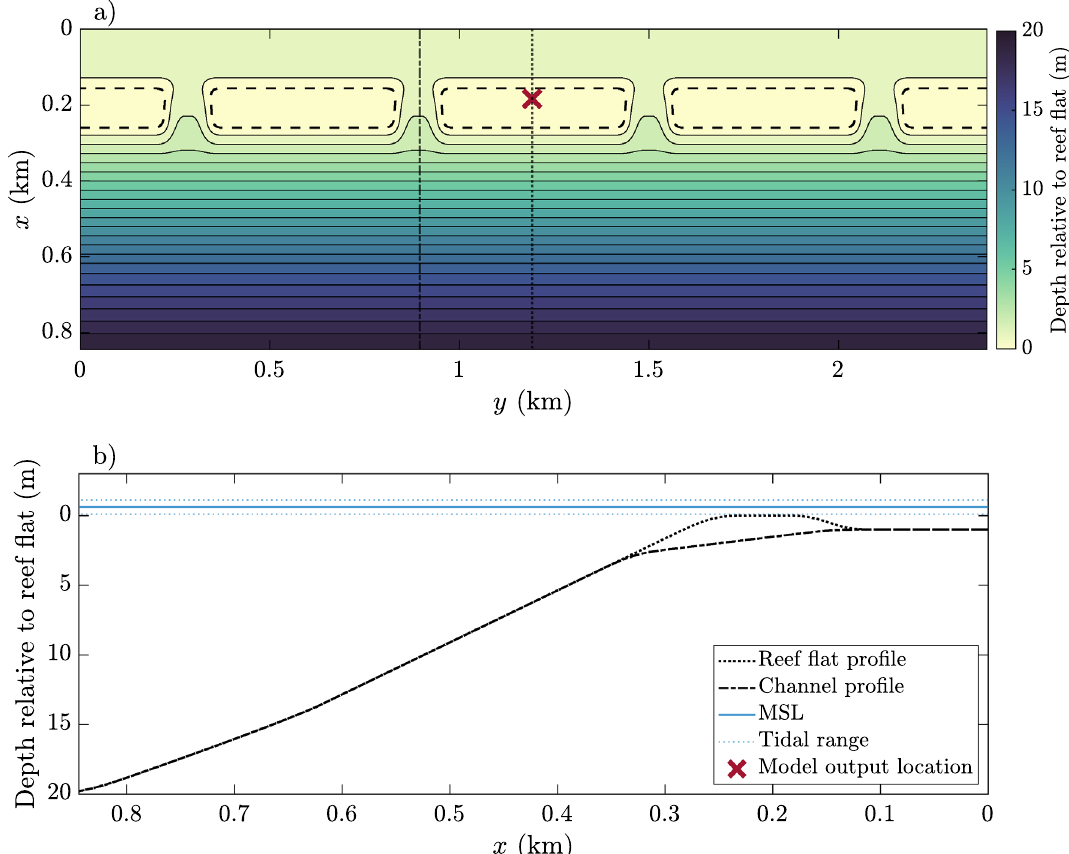
Figure 2. Model domain. ( a ) Bathymery. The area within the bold, dashed lines indicates the reef flats and the part of the domain where the drag coefficient is varied between model runs. Vertical dotted (dot-dash) line indicates profile along the reef flat (channel) in ( b ). The red marker shows the location of model outputs in Figs. 8 and 9. ( b ) Depth profile of the model domain, mean sea level (MSL) and tidal